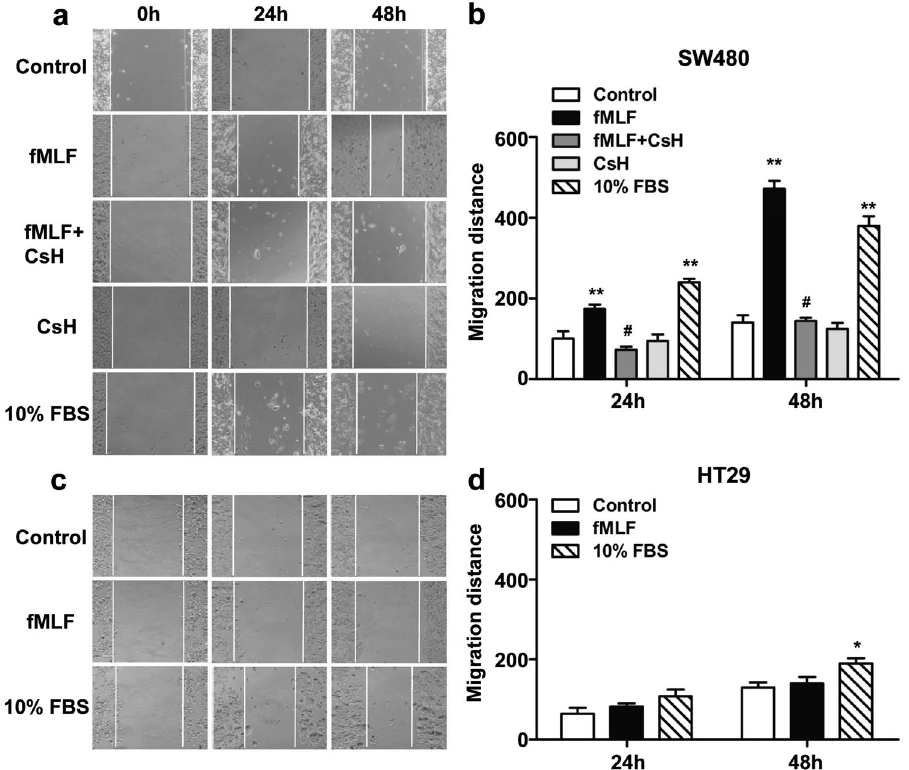
Figure 5. FPR1 activation accelerated the migration of SW480. The motility of SW480 ( a , b ) and HT29 ( c , d ) in wound-healing model was assayed in the presence of fMLF (1 μ M) or 10% FBS with or without a 15 min pretreatment with cyclosporine H (1 μ M). Then cells were photographed at 24 h and 48 h. * p < 0.05 compared with control, # p < 0.05 compared with the cells treated with fMLF. All the data shown are mean ± SEM from three separate experiments, each in